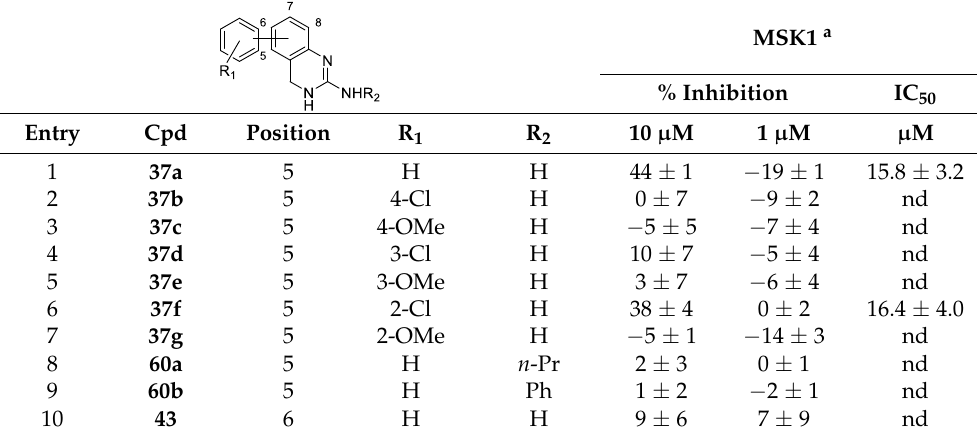
it did not improve the potency compared to 37a . A steric hindrance around the exocyclic nitrogen (Table 4) has been shown with the inactivity of the N-propyl ( 60a ) and N-phenyl ( 60b ) derivatives. Table 4. Dihydroquinazolines derivatives. Table 4. Dihydroquinazolines derivatives.